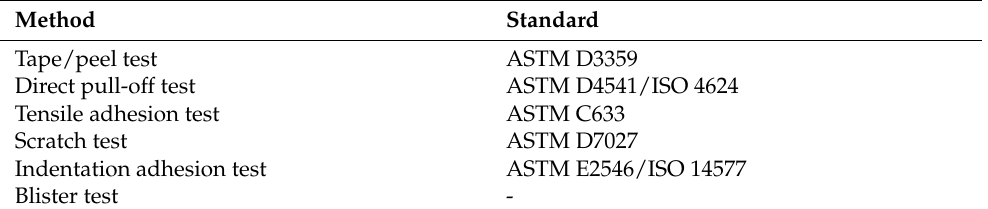
Table 3. Standards for adhesion measurement techniques for metallic substrates